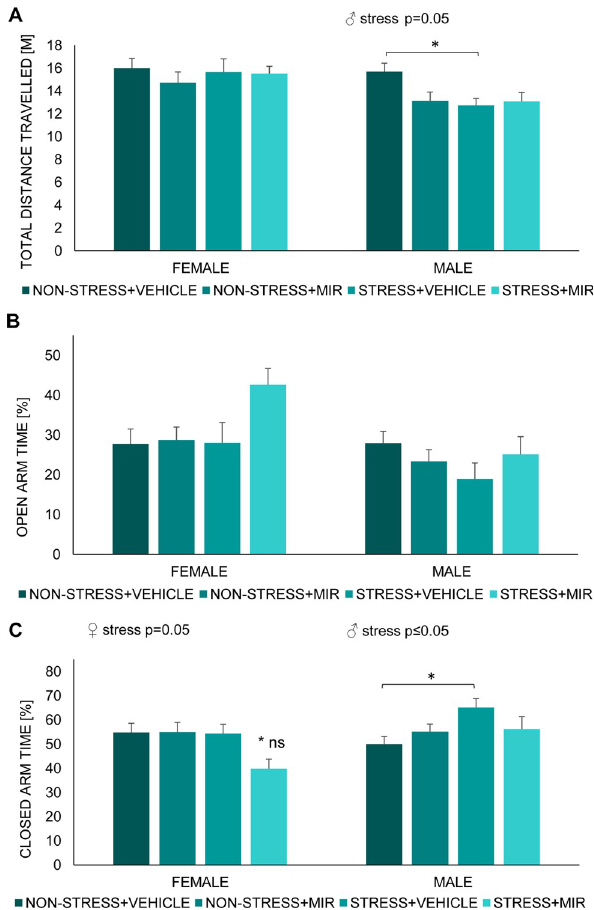
Fig 7. Elevated plus maze of adolescent offspring. (A) total distance travelled, (B) open arm time percentage, (C) closed arm percentage. Data represent mean ± SEM. n = 7–10 animals/group/sex. ns- compared to both non-stress groups; � p �